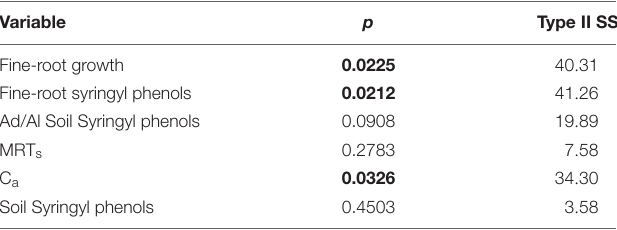
TABLE 4 | Partial regression results for the effects of six explanatory factors on SOC stocks. Variable